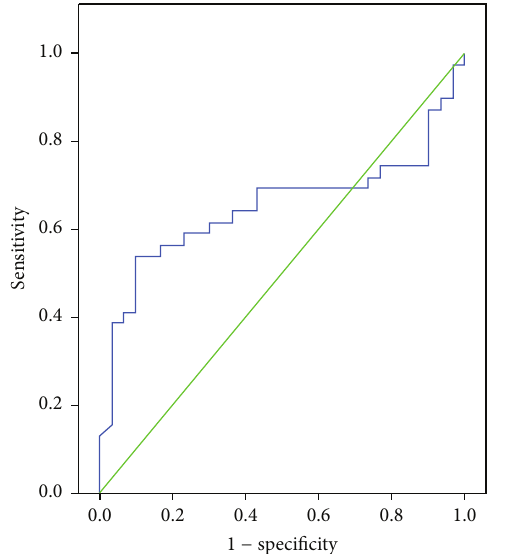
Figure 2: Receiver operating characteristics (ROC) curve for adiponectin level in predicting the presence of adrenal inciden- taloma (AI).